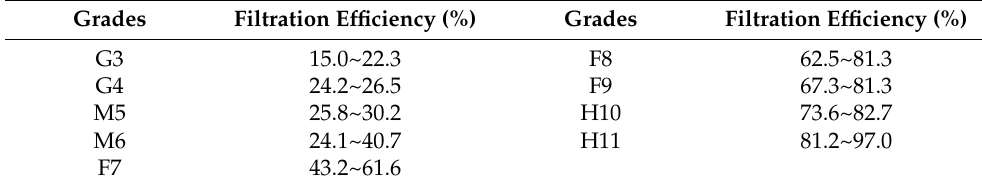
Table 6. PM2.5 filtration efficiency of different grades of air filters.